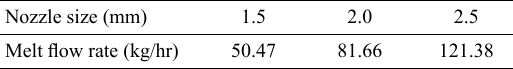
Table 1. Average melt flow rates for different nozzle sizes